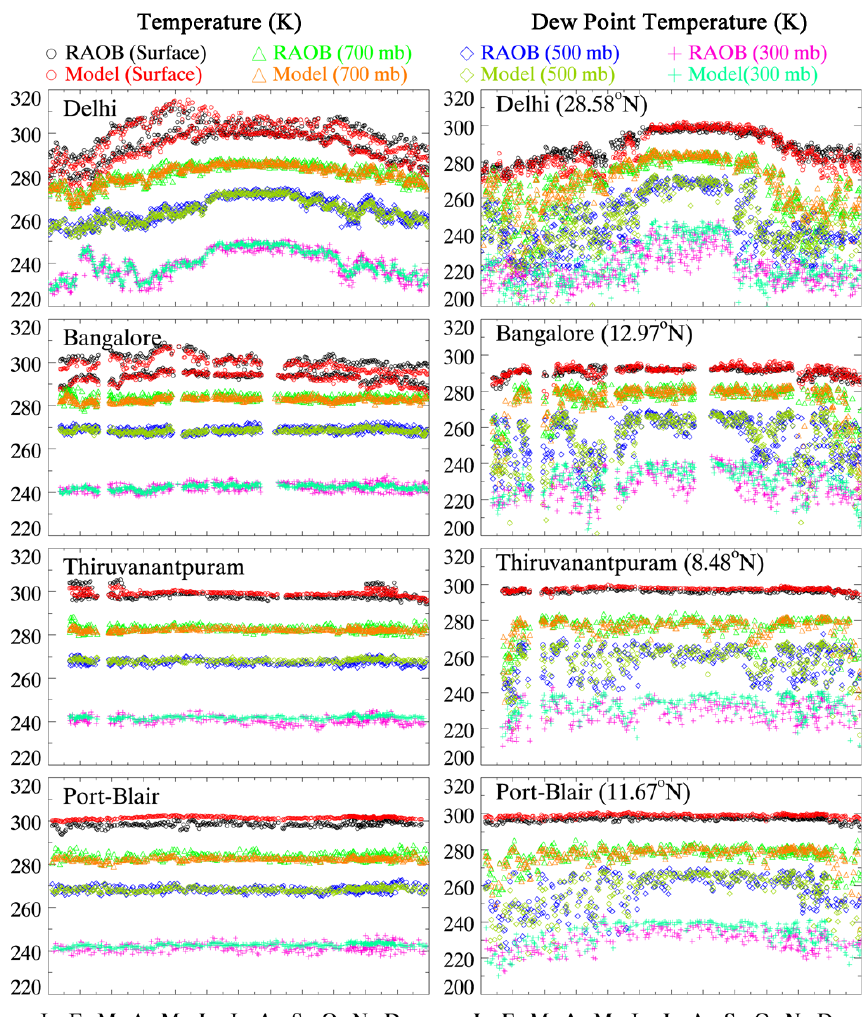
Fig. 11. Seasonal variation of co-located observed and the model simulated temperature (left panels) and dew point temperature (right panels) at the surface, 700hPa, 500hPa and 300hPa for Delhi (low altitude), Bangalore (moderately high altitude), Thiruvanantpuram (coastal) and Port-Blair (island) during